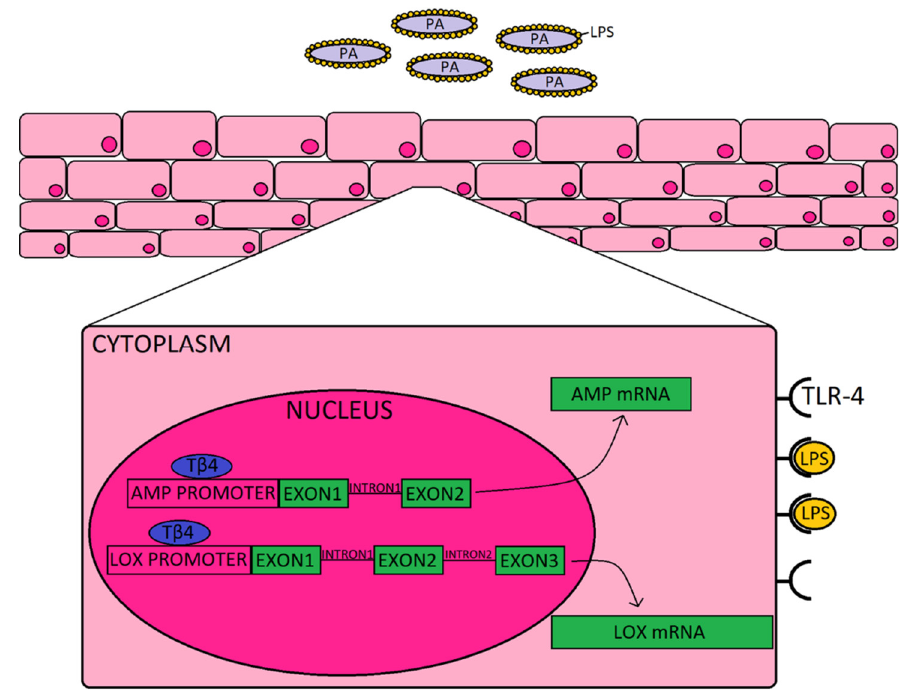
Figure 4. Schematic representation of how T β 4, as an adjunct to ciprofloxacin may be enhancing the corneal epithelial cell response to Pseudomonas (purple) and LPS (yellow) binding to TLR4. It is proposed that T β 4 (blue) may act as a transcription factor that is shown to bind to the promoter region, as indicated by the generalized representation shown for both AMPs (and related molecules) and lipoxygenase enzymes.